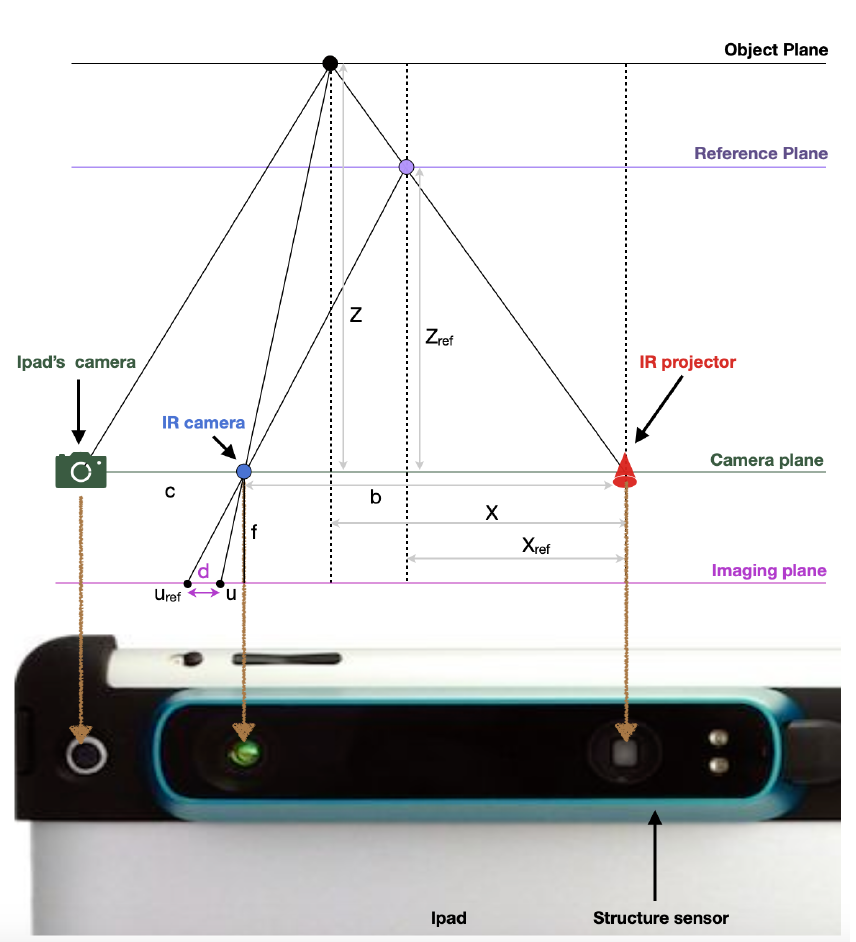
Figure 4. Explanation of the geometry of converting disparity to depth used by the Structure Sensor (adapted from the work in [28]).